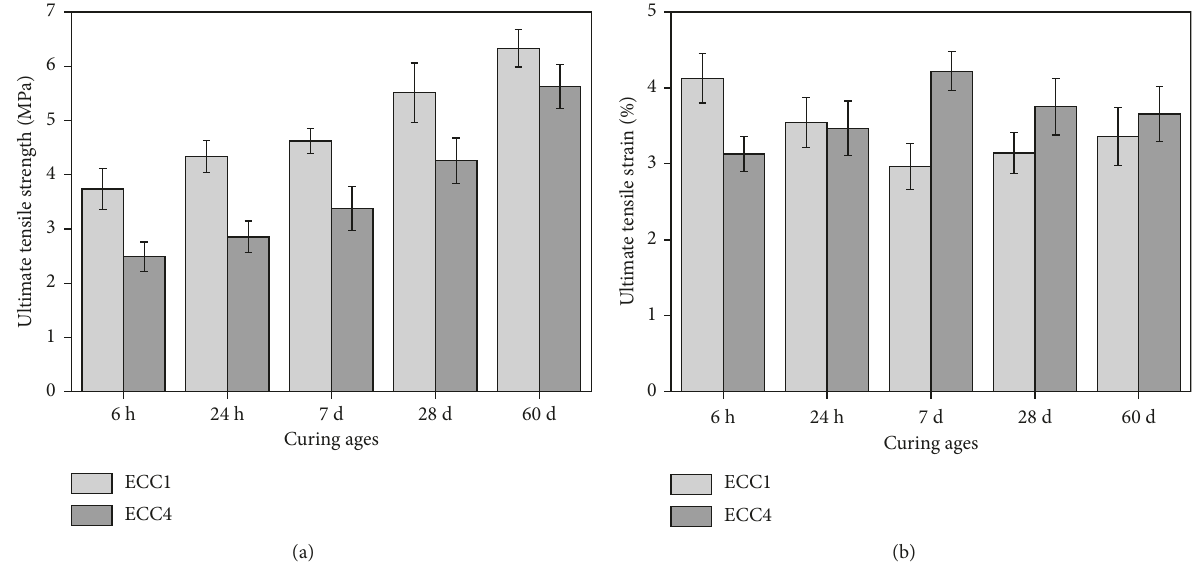
Figure 17: Comparison of tensile properties of ECC1 and ECC4 at different ages: (a) ultimate tensile strength; (b) tensile strain